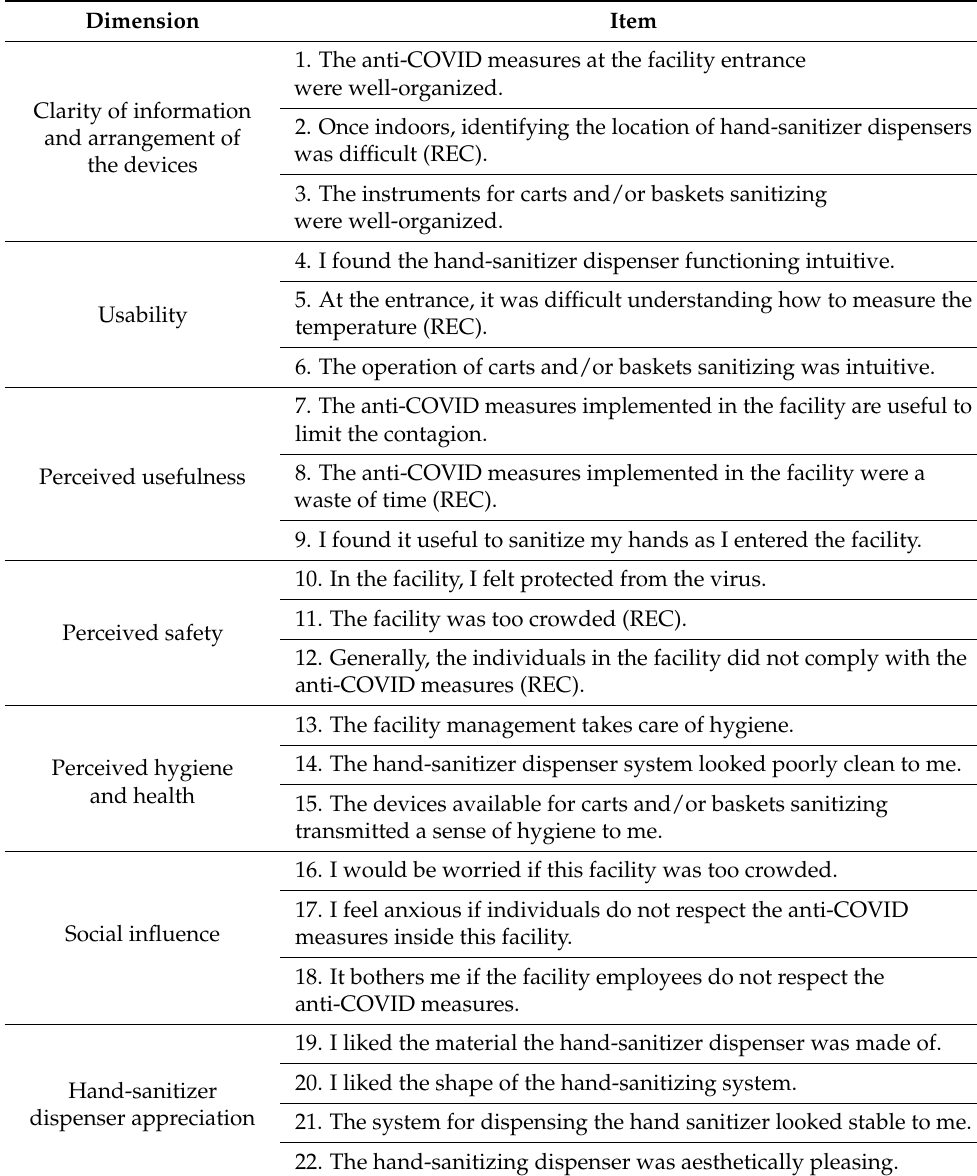
Table 6. Dimensions and items of the case study questionnaire concerning the general implementation of the anti-COVID measures and the used devices. Own processing.